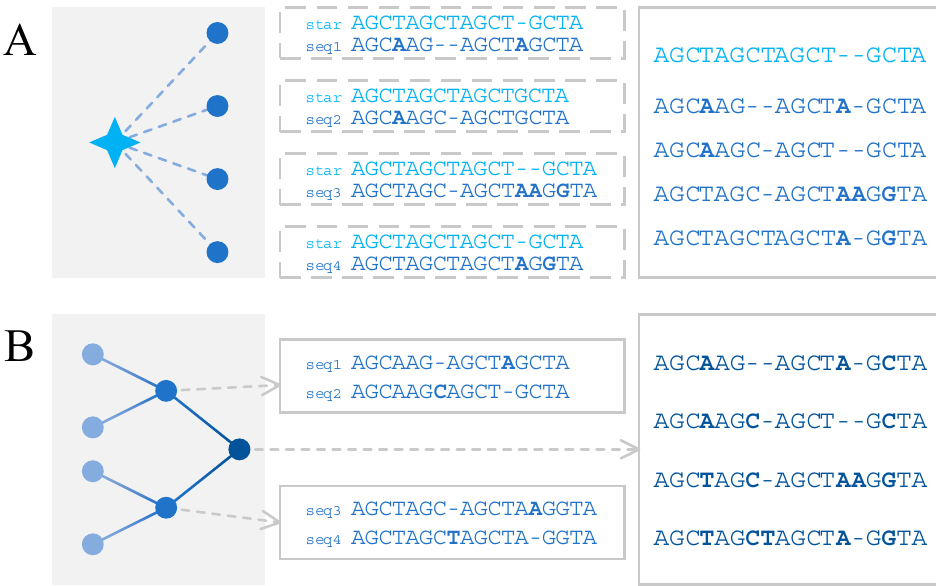
Figure 2. Two strategies for multiple sequence alignment. ( A ) Star alignment strategy performs multiple sequence alignment based on the consistencies among pairwise alignments of the sequences pending alignment and a center sequence, which is in light blue. ( B ) Progressive alignment strategy performs multiple sequence alignment along a pre-built guide tree, each of whose internal nodes represents an alignment of two sequences, one sequence with one profile, or two profiles.